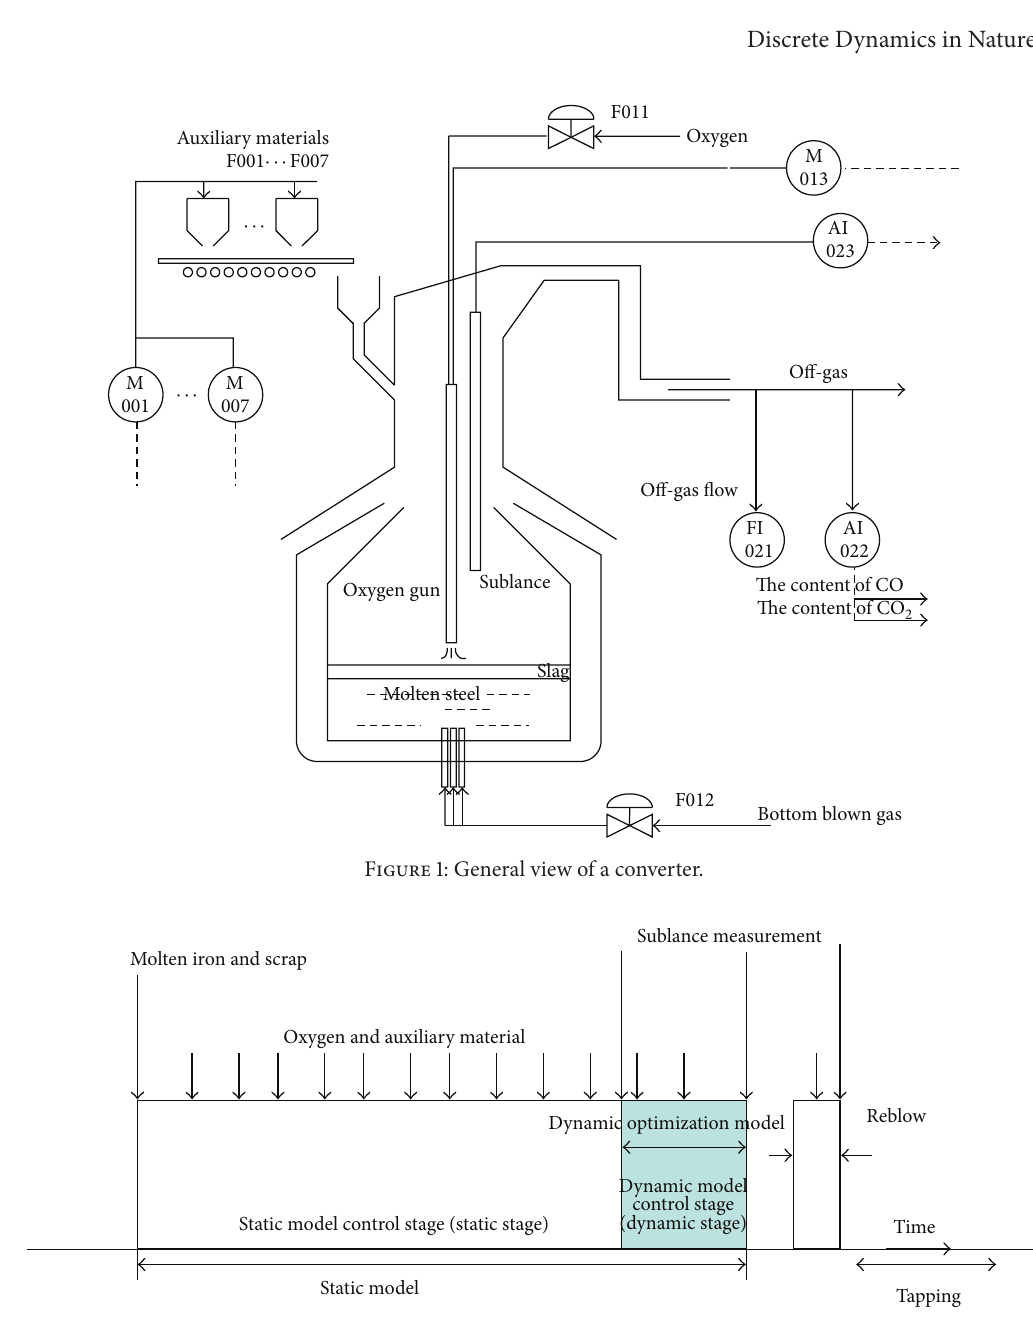
Figure 2: Converter steelmaking production and main control